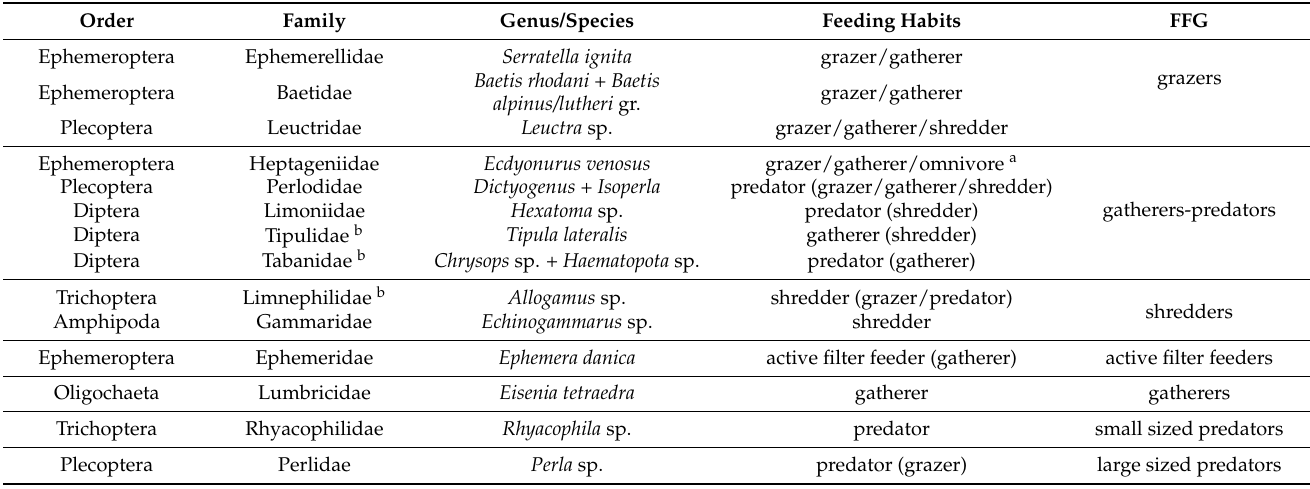
Table 1. Invertebrate taxa collected during the study, taxonomic identification, main feeding habits (in brackets, secondary feeding habits are reported) according to literature [40] and Functional Feeding Groups (FFG) used to group the organisms for statistical